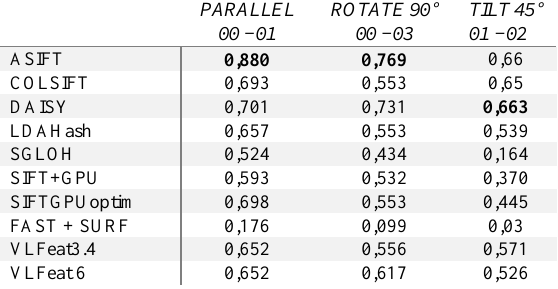
Table 3: Efficiency of each operator.